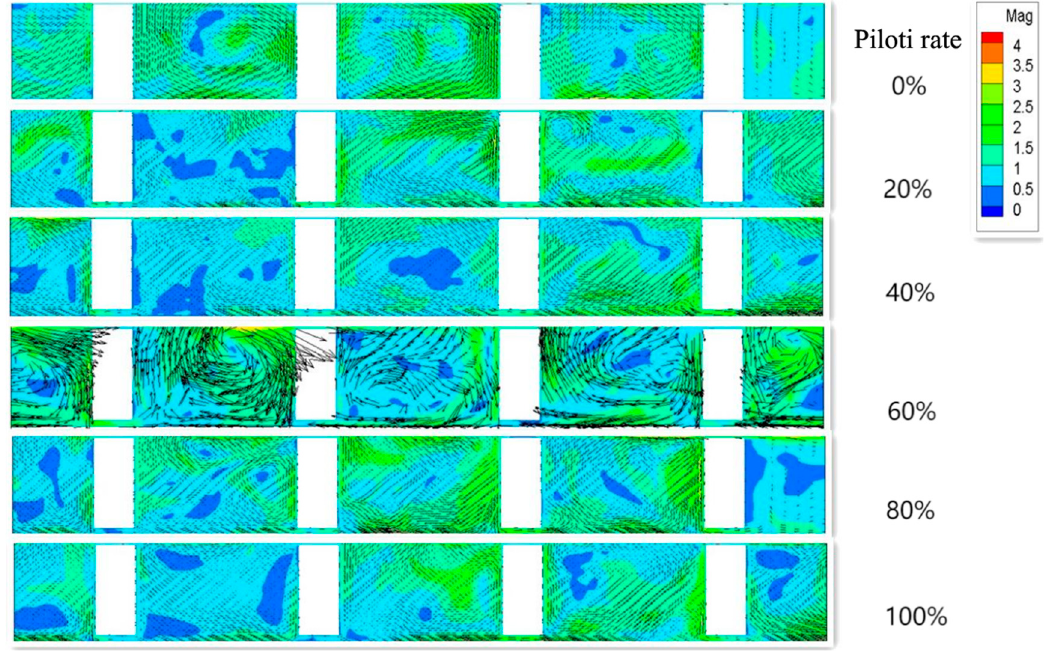
Figure 9. Vector diagram of the target area of Section 1 (Determinant model).